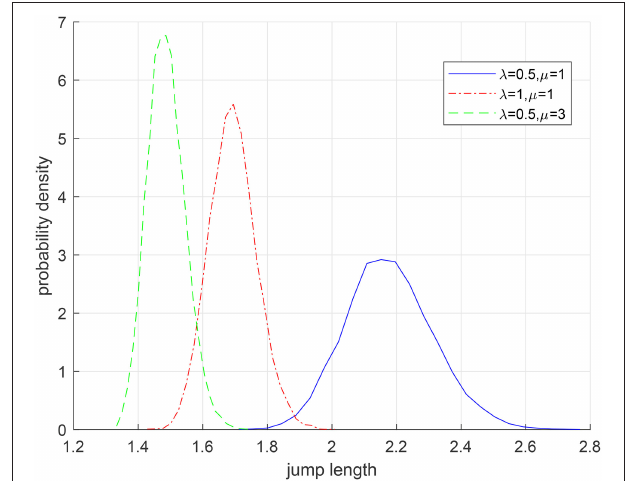
FIGURE 9 | A typical example of foraging procedure with λ = 1 and µ = 1.